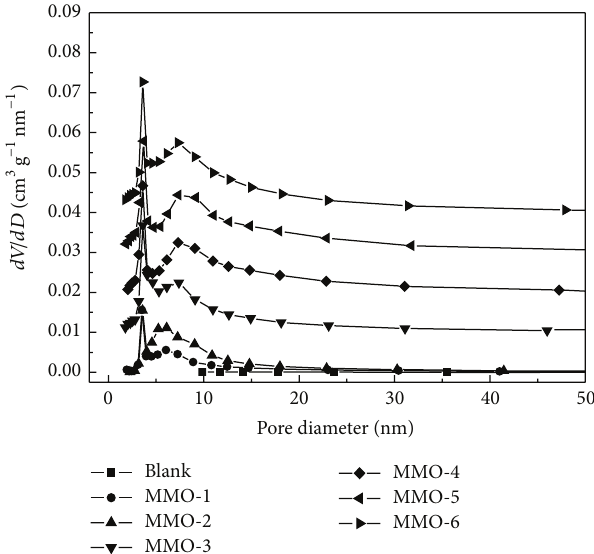
Figure 4: Mesopore size distributions of the samples of blank and MMO- 𝑥 ( 𝑥 = 1–6).